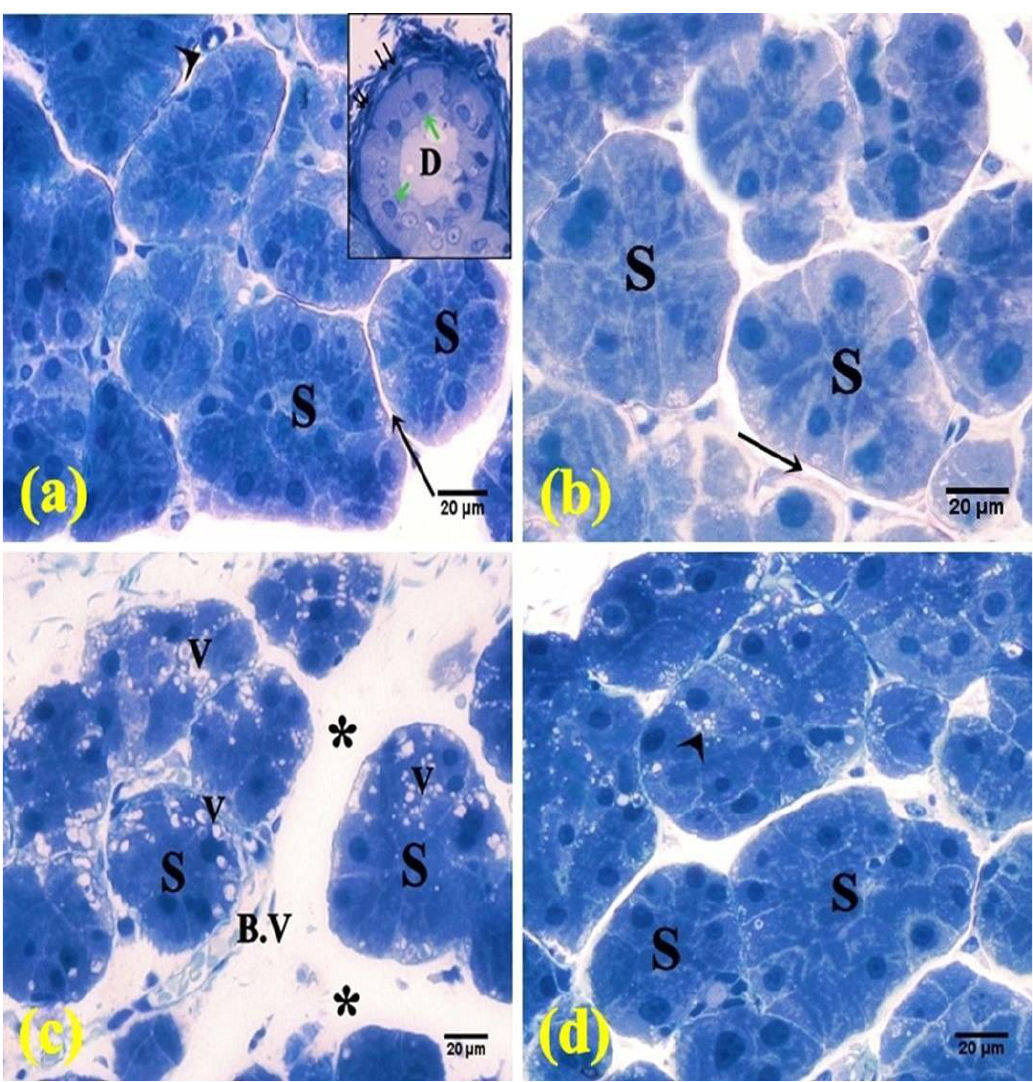
Figure 3. Photomicrographs of semi-thin sections of the parotid salivary gland. ( a , b ) The control and FEB groups, respectively, showed intact parenchyma with packed serous acini (S), thin septa ( ↑ ), and blood vessel (arrowhead). Inset: striated duct (D) lined by low columnar cells (green arrow) and surrounded with myoepithelial cells ( ↑↑ ). ( c ) The 5-FU group showed serous acini (S) separated by wide spaces (*) and congested blood vessel (B.V). Notice the vacuolation (V). ( d ) The FEB + 5-FU group showed packed acini with few vacuolations (arrowhead). (Toluidine blue × 400; 8